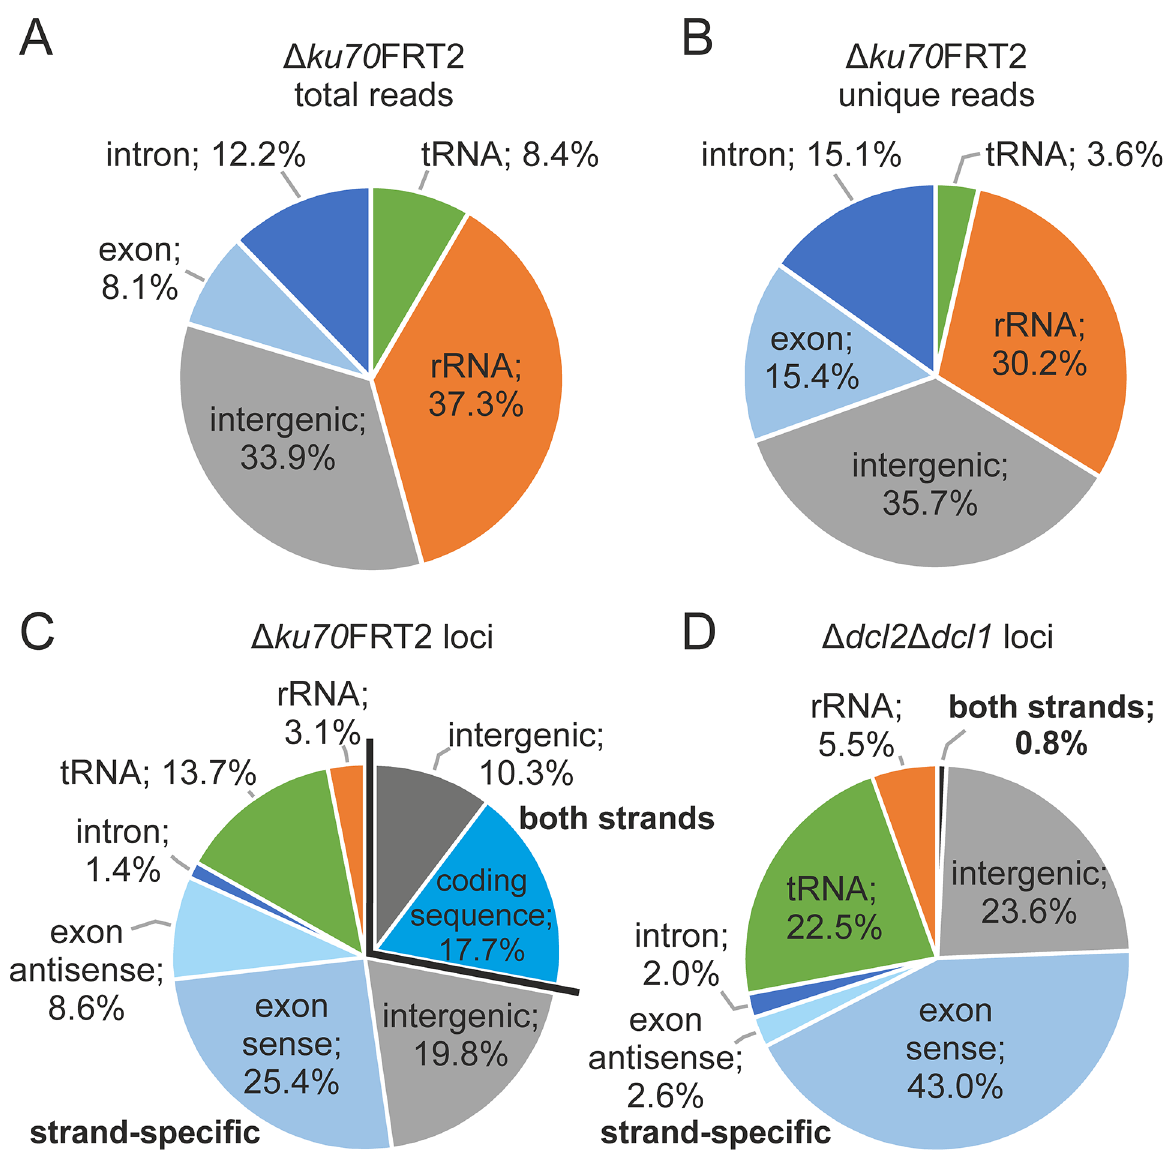
Fig 1. Chromosomal distribution of small RNAs and sRNA-producing loci. Pie graphs for total reads (A) and unique reads (B) are showing the relative abundance of sRNAs located in tRNAs, rRNAs, intergenic, exonic and intronic regions in Δ ku70 FRT2. Alignments of sRNA-producing loci of Δ ku70 FRT2 (C) and Δ dcl2 Δ dcl1 (D) show that the number of sRNAs that map to both DNA strands of one feature have strongly increased and that the fraction of sRNA loci that align to exonic regions in sense orientation has decreased substantially in Δ dcl2 Δ dcl1 compared to Δ ku70 FRT2.